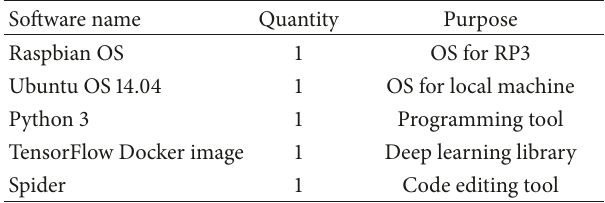
Table 3: Software